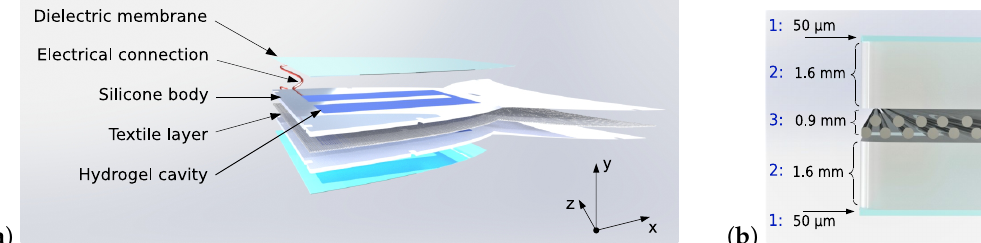
Figure 2. Layered setup of ( a ) the robot with DEAs on both outer sides and ( b ) the symmetric arrangement of single layers and their corresponding thicknesses consisting of the dielectric films for the DEAs (1), the silicone layer with the included hydrogel cavities of the same thickness (2) and the textile layer (3) in the neutral plane.